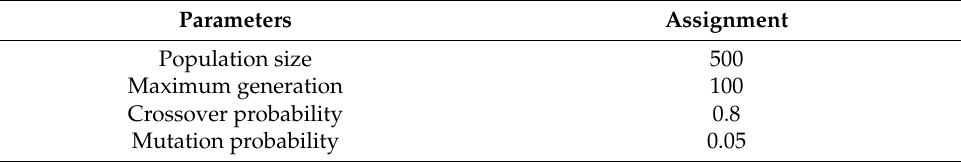
Table 4. Initial parameters of the genetic